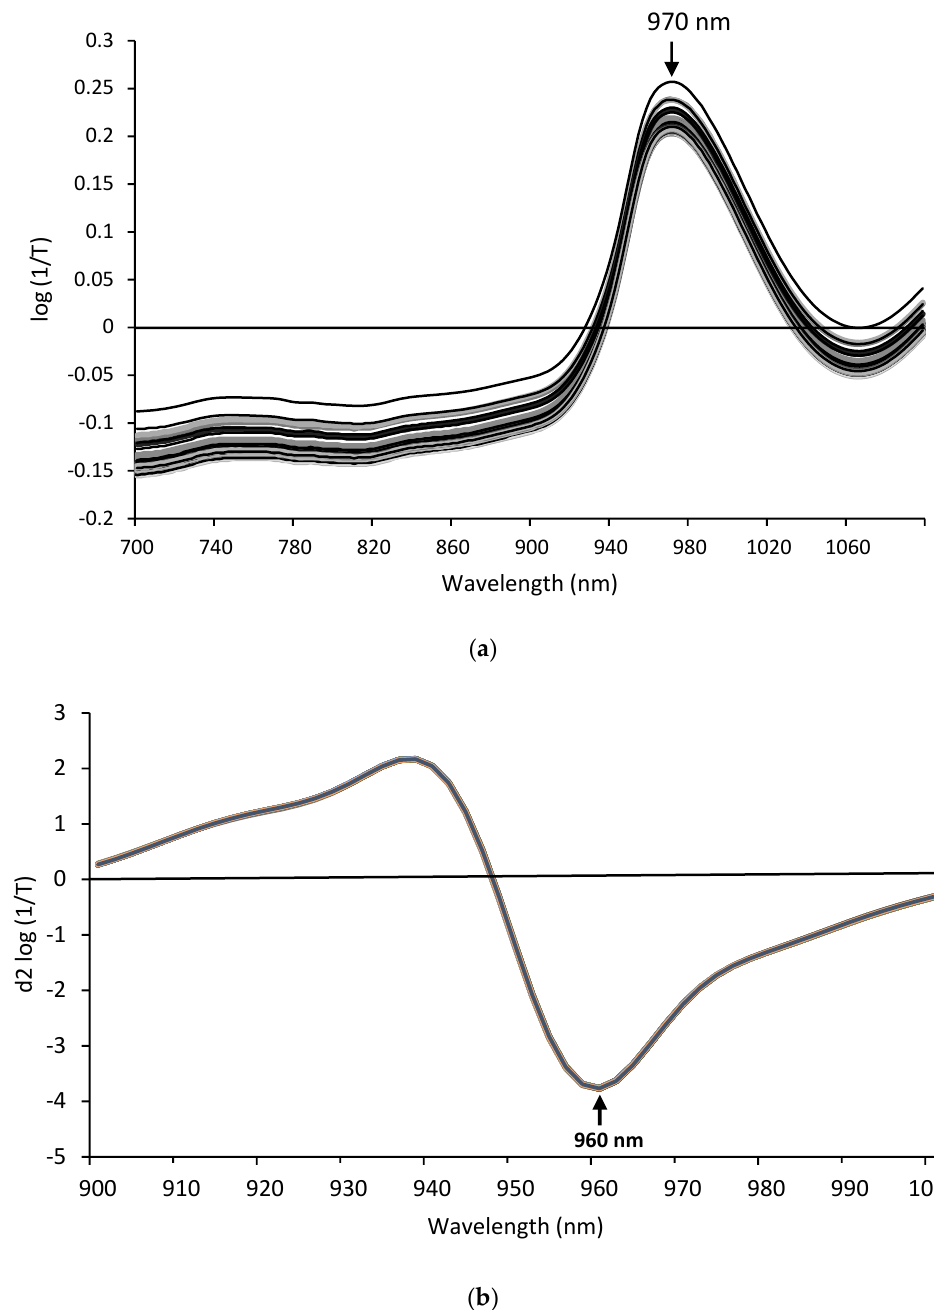
Figure 5. The NIR spectra of 5 types of sample solutions at 0 h–14 days. ( a ), original spectra; ( b ), second derivative spectra used for discriminant analysis. Different color lines indicate each NIR spectra of different sample solutions.